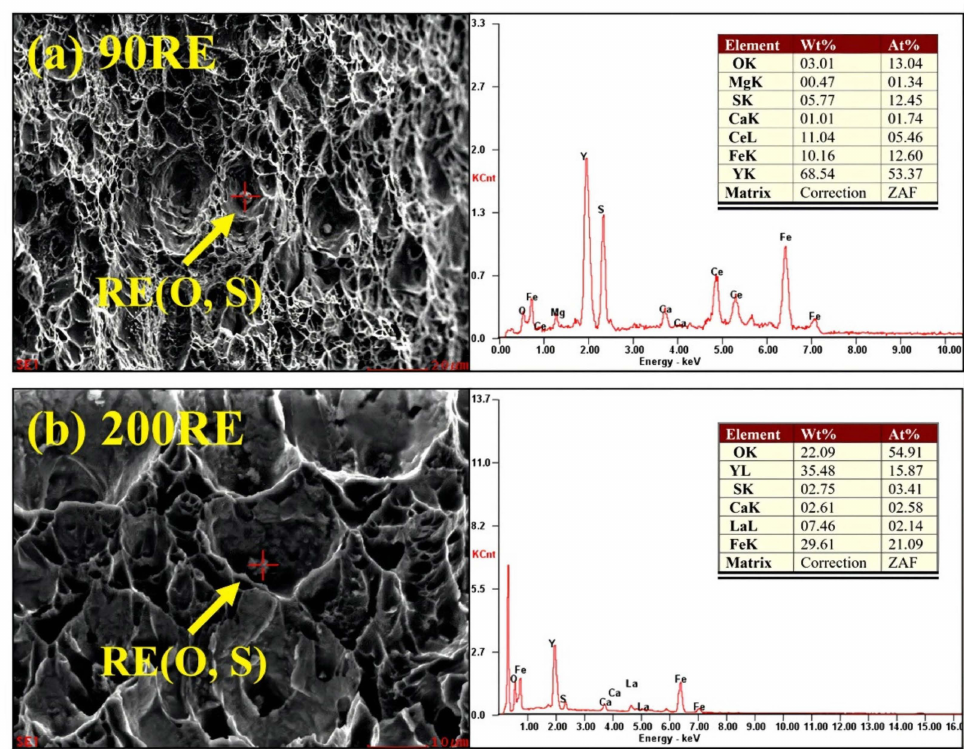
Figure 14. Impact fracture morphology and EDS of ( a ) 90RE steel and ( b ) 200RE